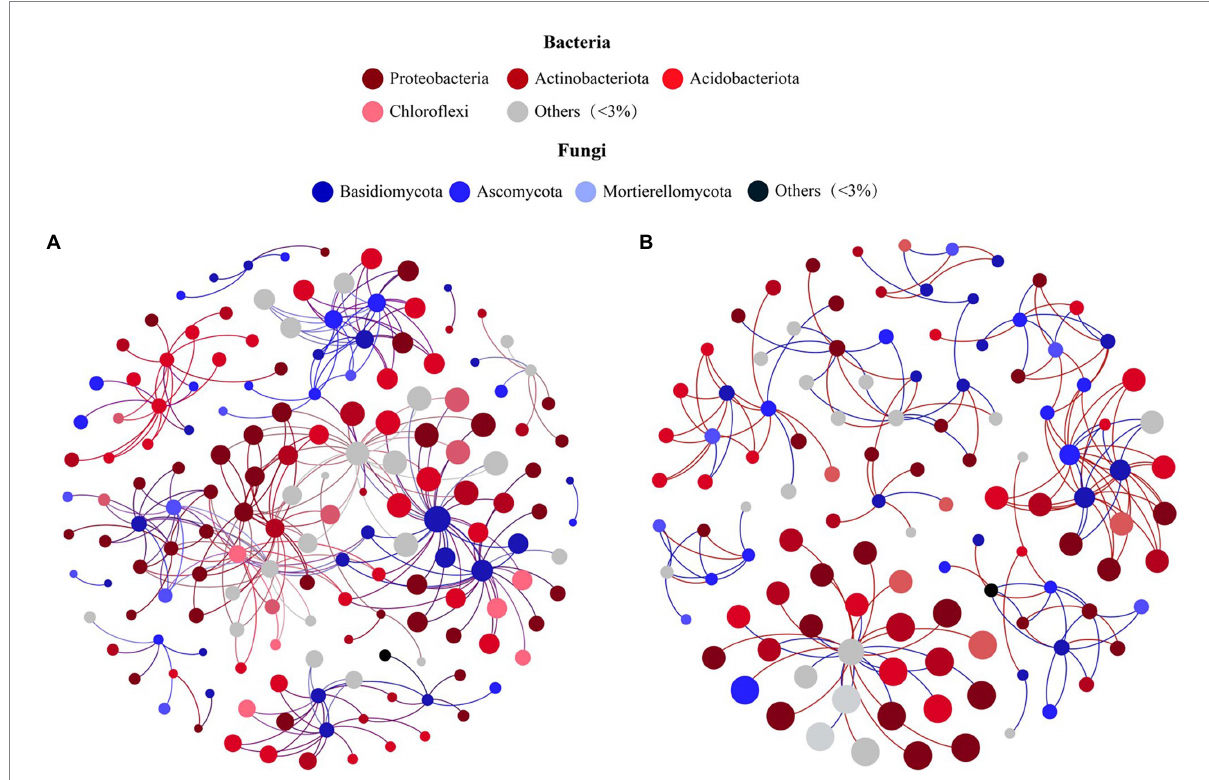
FIGURE 4 Co-occurrence networks showing the correlation between Bacteria and Fungi of Mount Segrila on (A) 3,700, 3,900, 4,100 m and (B) 3,500, 4,300 m. Points represent nodes (Species) and lines (edges) represent significant correlations between nodes. Red lines colors represent positive correlations; Blue lines colors represent negative